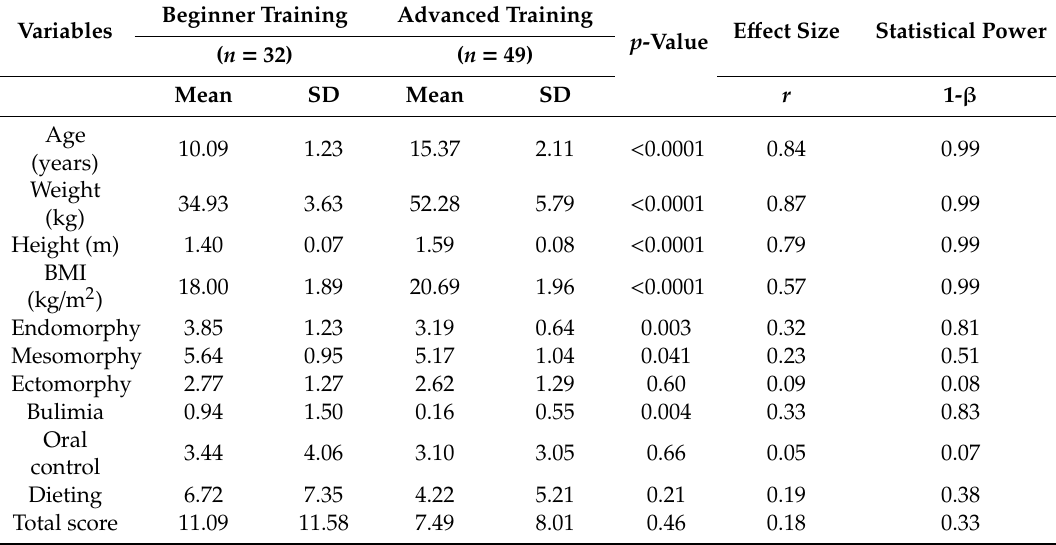
Table 1. Descriptive data for anthropometrics and the Eating Attitudes Test-26 (EAT-26) subscales of the study groups.